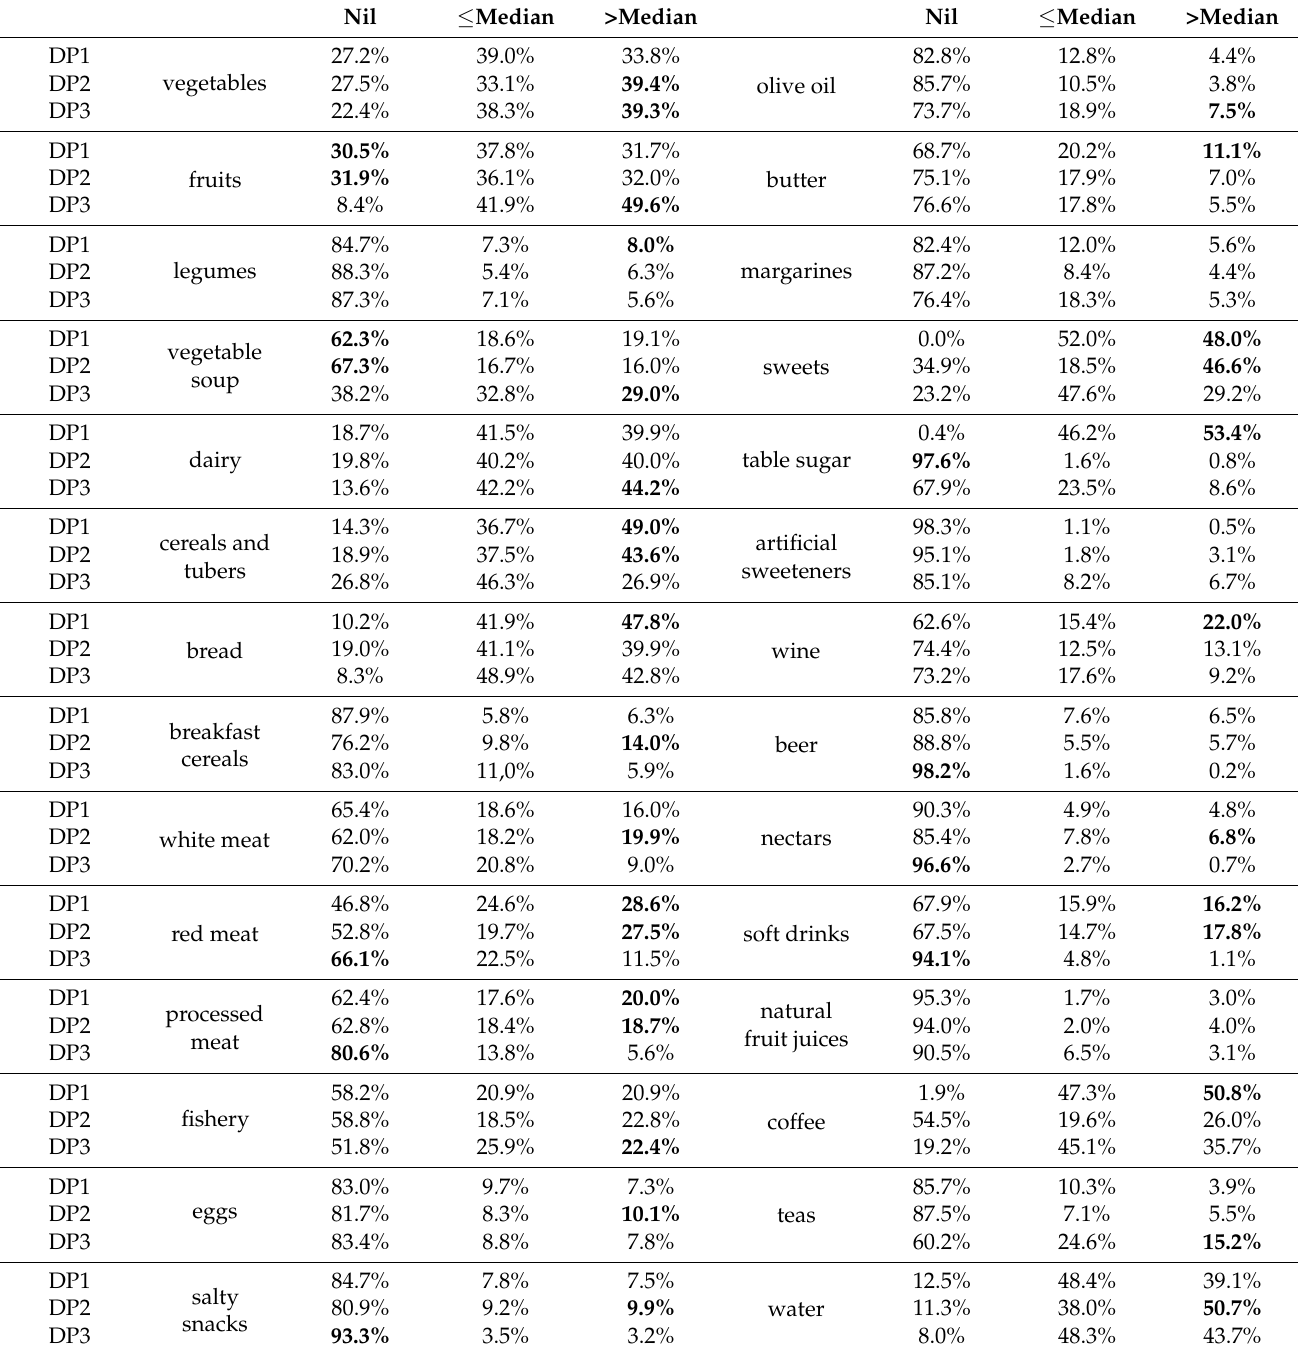
Table 2. Probabilities of food group consumption 1 conditional on a dietary pattern derived by the latent transition model with concomitant variables (age and sex) 2